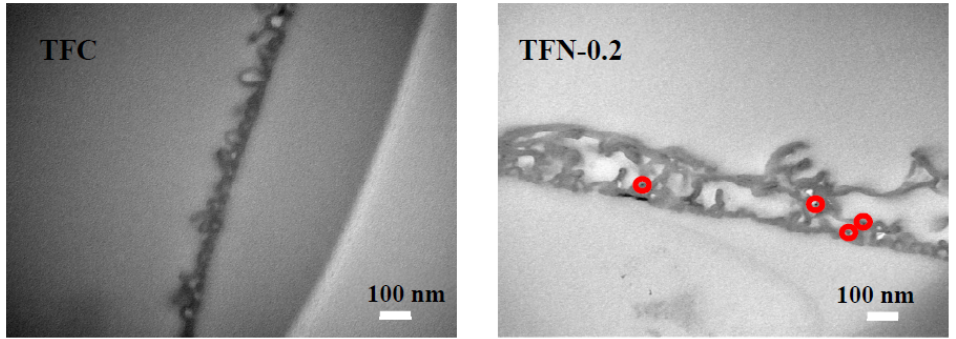
Figure 4. TEM images of the thin-film composite (TFC) and TFN membranes.